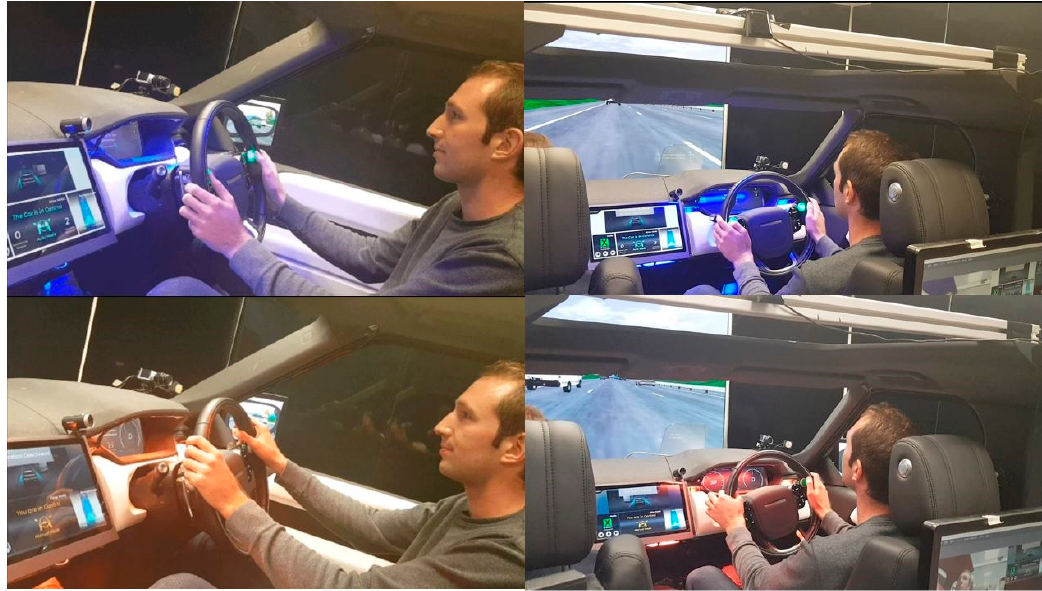
Figure 6. Four views of the driving simulator, top left and right show the vehicle was under automated control (where the ambient light colour is blue) and the bottom left and right panels show that the vehicle was under manual driver control (where the ambient light colour is orange).